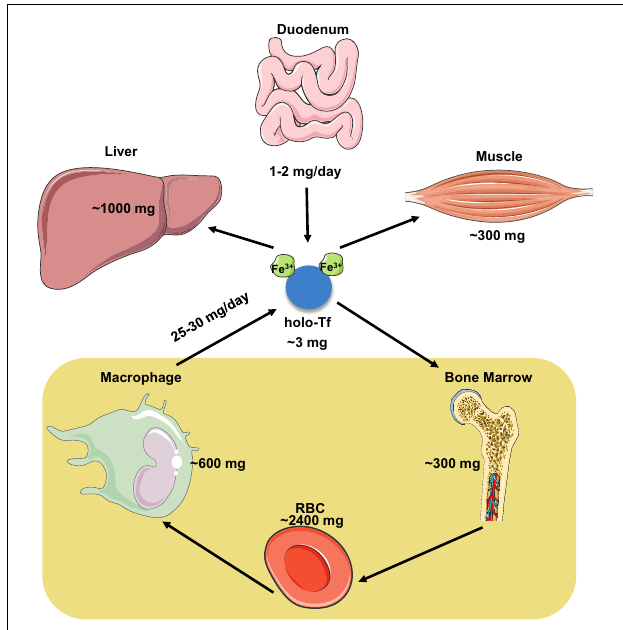
FIGURE 1 | Distribution and dynamics of iron traffic in the human